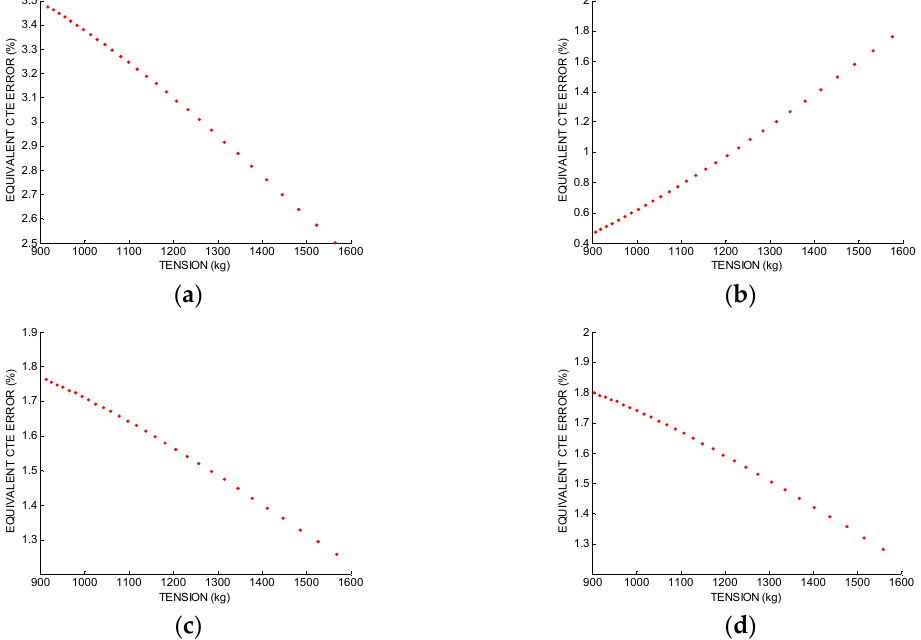
Figure 5. Equivalent coe ffi cients of thermal expansion (CTE) error. ( a ) 2% weight error; ( b ) 5% modulus of elasticity error; ( c ) 1% span length error; ( d ) 2% insulating string